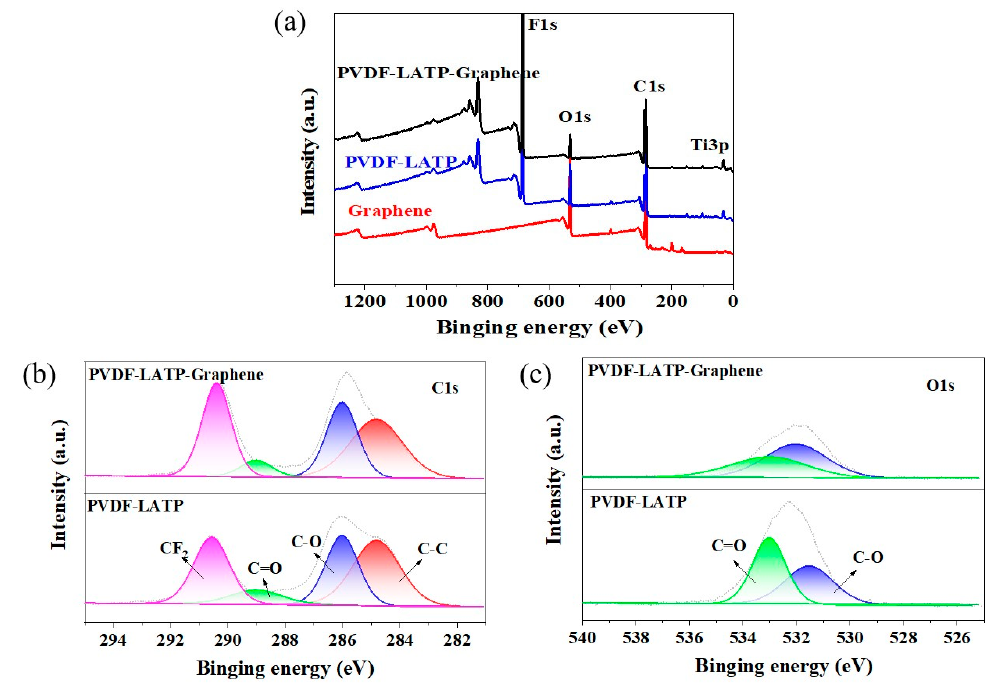
Figure 5. ( a ) XPS spectra of graphene, PLL and PLLG: ( b ) C 1s and ( c ) O 1s.